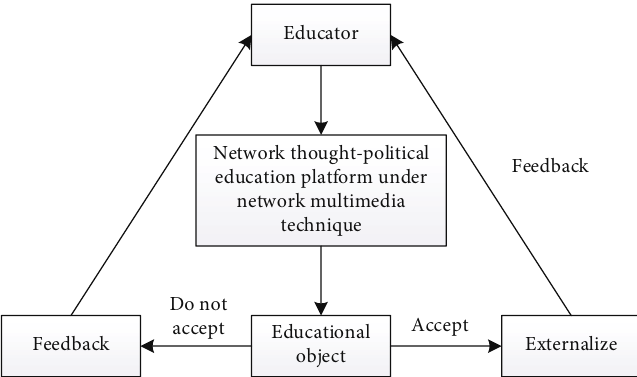
Figure 1: The realization process of thought-political education under the net multimedia